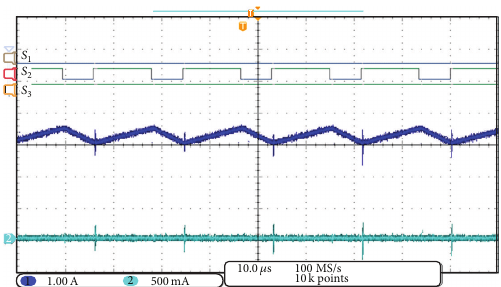
Figure 12: Operation when the energy is obtained from the renewable source. From top to bottom: 𝑆 1 , 𝑆 2 , 𝑆 3 , 𝐼 𝐿 current reference of both inductors is the same.